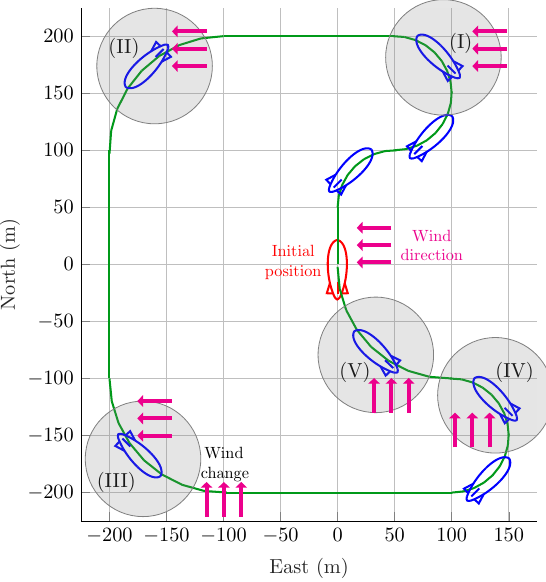
Figure 5. Simulation trajectory for wind estimation.